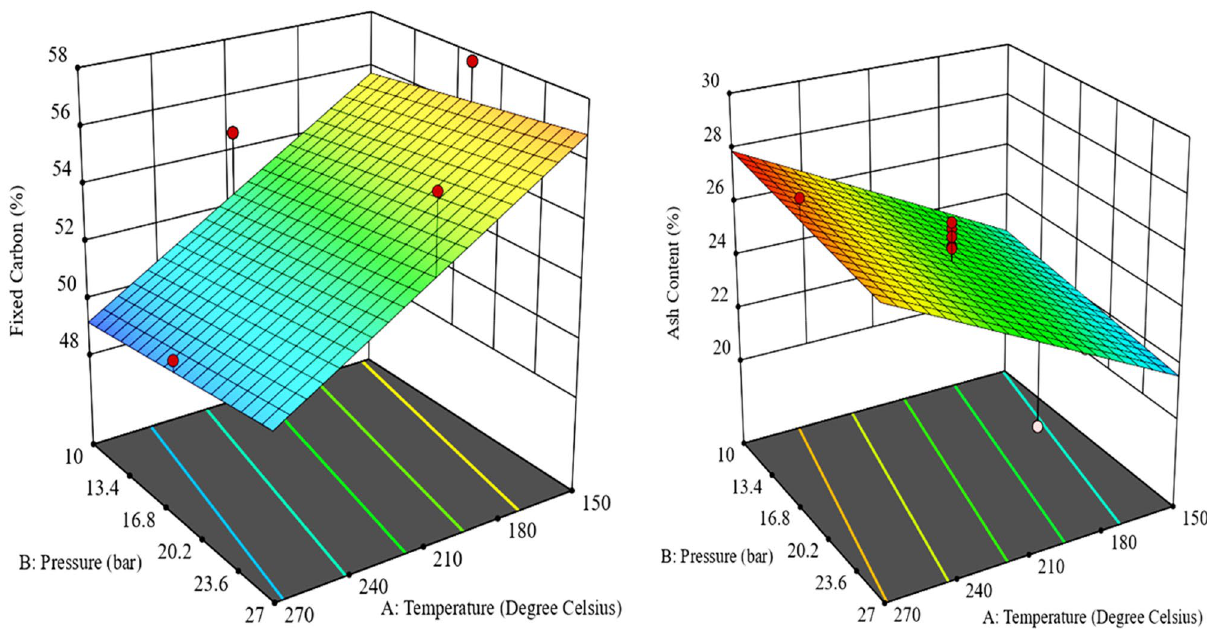
Figure 6. Surface plot showing the influence of temperature and pressure on fixed carbon (left) and Ash content (right) of Coal slurry’s HC.